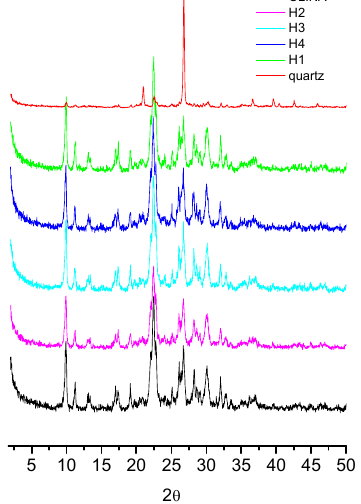
Figure 3. X ‐ ray powder ‐ diffraction pattern of natural and modified clinoptilolite. Figure 3. X-ray powder-diffraction pattern of natural and modified